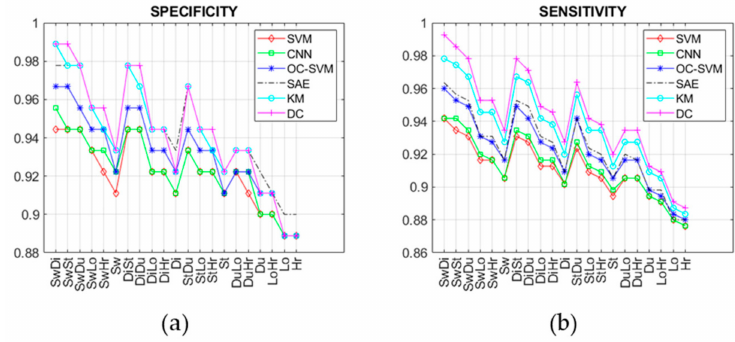
Figure 15. ( a ) Specificity and ( b ) sensitivity of all compared techniques.